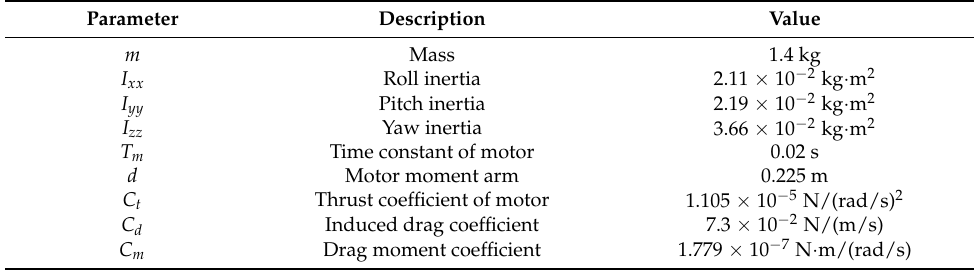
Figure 8. The real-time hardware-in-loop simulation platform. Table 3. Main quadrotor parameters used in